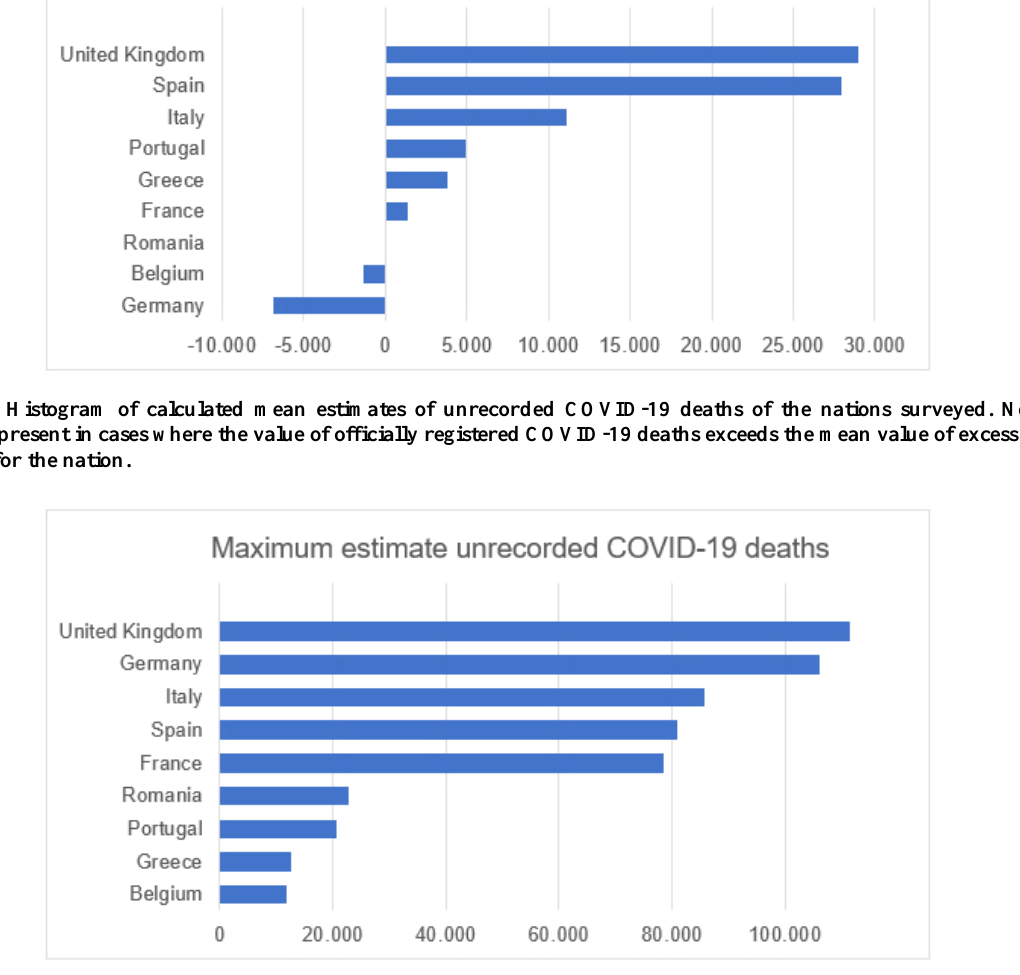
Figure 22. Histogram of calculated maximum estimates of unrecorded COVID-19 deaths in the nations